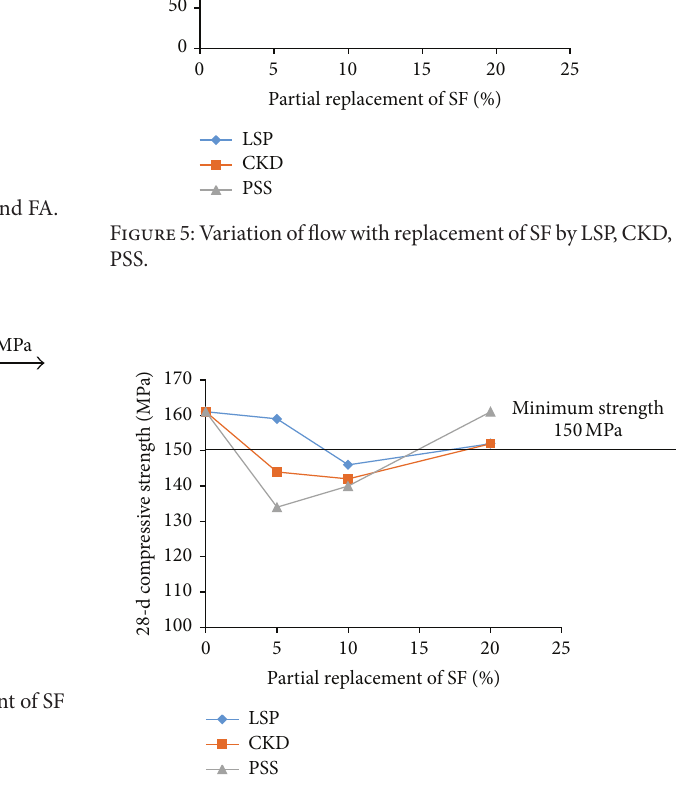
Figure 6: Variation of compressive strength with replacement of SF by LSP, CKD, and PSS.